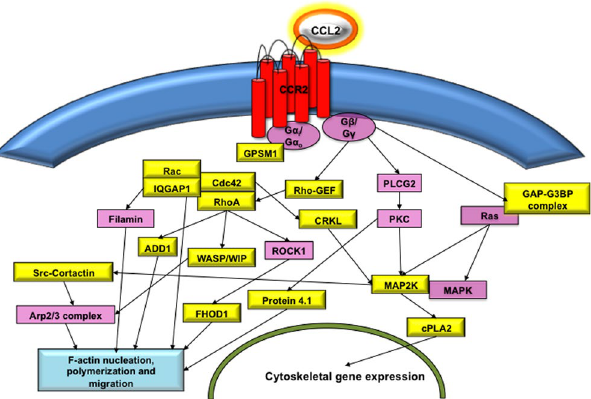
Figure 3. Phosphoproteomic analysis of CCL2 treated DCs and confirmation of relevant signaling pathways. Schematic of actin and MAPK related proteins from pathway analysis of identified proteins from the CCL2 treated samples (yellow- phosphorylated protein, pink- molecules linking identified phosphorylation events). (See also Figure